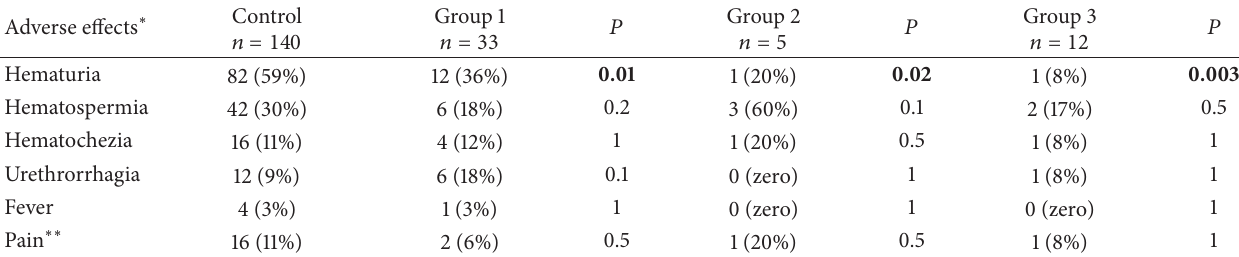
Table 1: Correlation between prostate biopsy adverse effects and pharmacological treatment for benign prostatic hyperplasia. Adverse effects